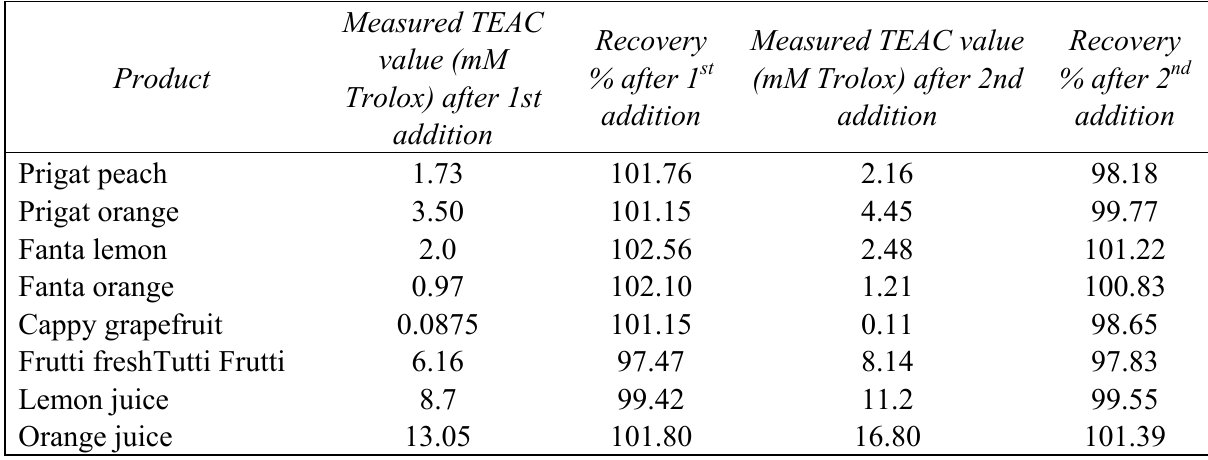
Table 2 . Determination of the degree of recovery of known concentrations of Trolox introduced in the analysed samples, by using the biamperometric